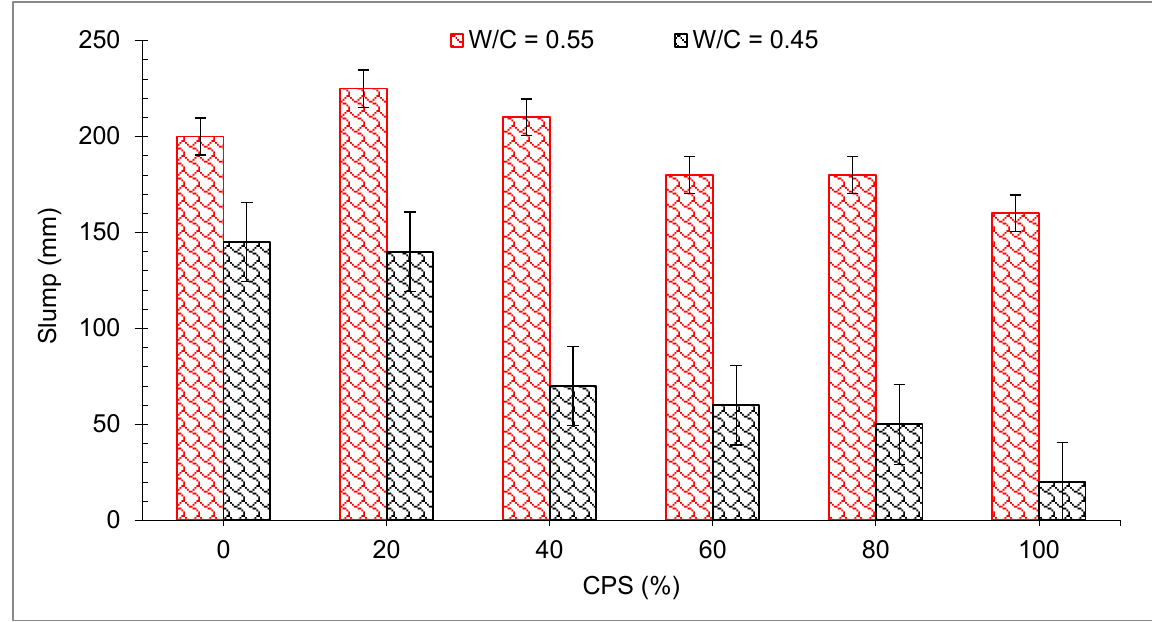
Figure 5. Workability of concrete [47].